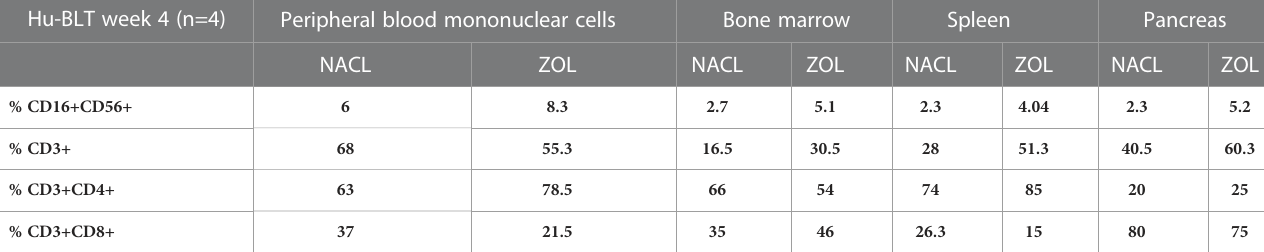
Hu-BLTmicewereadministeredwitheither0.9%NACLorZOL(500μg/kg) via IVfollowedbymaxillaryleft fi rstmolarextractionasdescribedinMaterialsandMethodssection.Fourweeksafter tooth extraction, mice were euthanized and tissues were harvested to obtain single cell suspension. Immune cell composition was determined in PBMCs (n=4), BM (n=4), splenocytes (n=4), and pancreas (n=3) of hu-BLT mice using fl ow cytometric